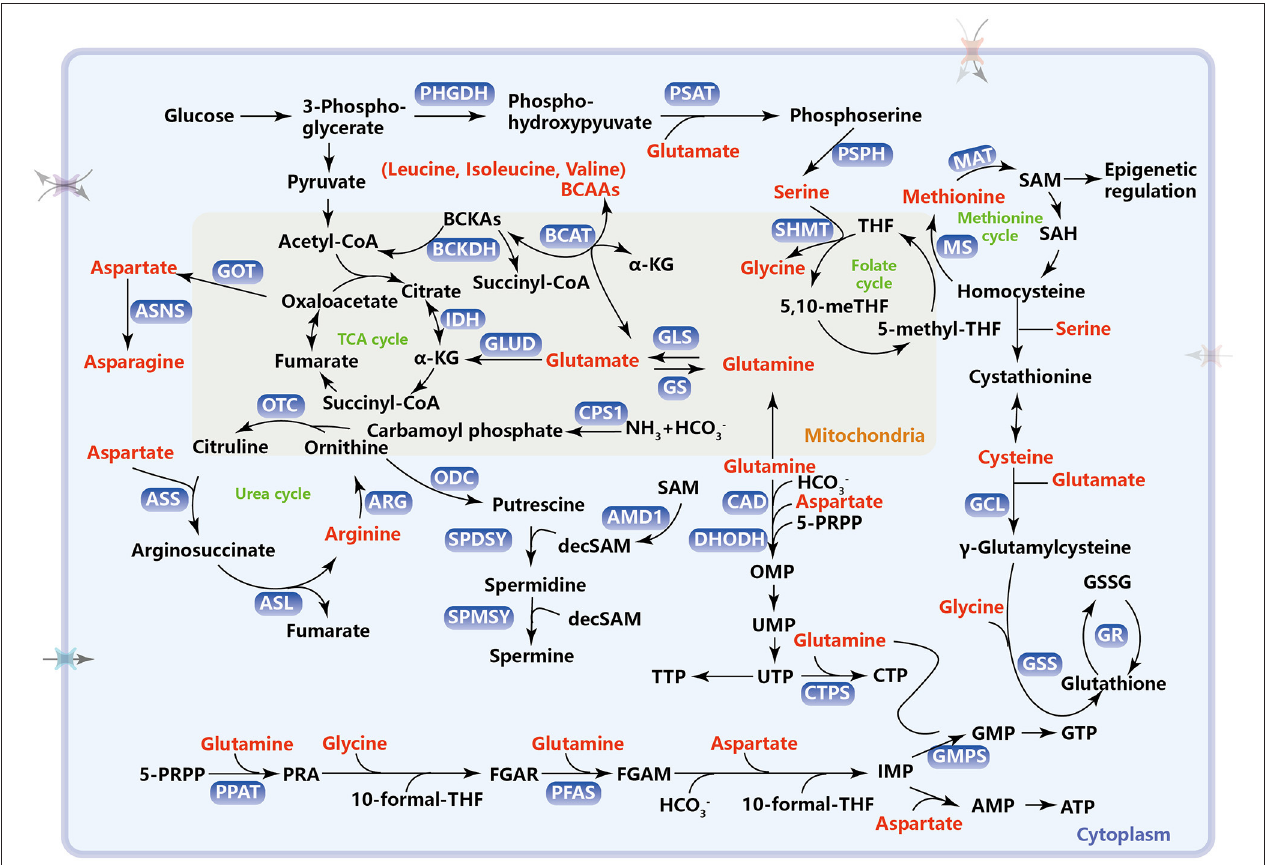
FIGURE 1 | Metabolic pathways of amino acids in cancer. This schematic diagram briefly summarizes the amino acid metabolism which includes one-carbon metabolism, TCA cycle, urea cycle, and intracellular antioxidant, reduced glutathione synthesis. PHGDH, phosphoglycerate dehydrogenase; PSAT, phosphoserine aminotransferase; PSPH, phosphoserine phosphatase; SHMT, serine hydroxymethyltransferase; THF, tetrahydrofolate; MS, methionine synthetase; MAT, methionine adenosine transferase; SAM, S-adenosylmethionine; SAH, S-adenosylhomocysteine; BCAAs, branched-chain amino acids; BCAT, branched-chain amino transferase; BCKAs, branched-chain α -ketoacids; BCKDH, BCKA dehydrogenase enzyme complex; GOT, aspartate transaminase; ASNS, asparagine synthetase; GLS, glutaminase; GS, glutamine synthetase; GLUD, glutamate dehydrogenase; IDH, isocitrate dehydrogenase; TCA, tricarboxylic acid; CPS1, carbamoyl